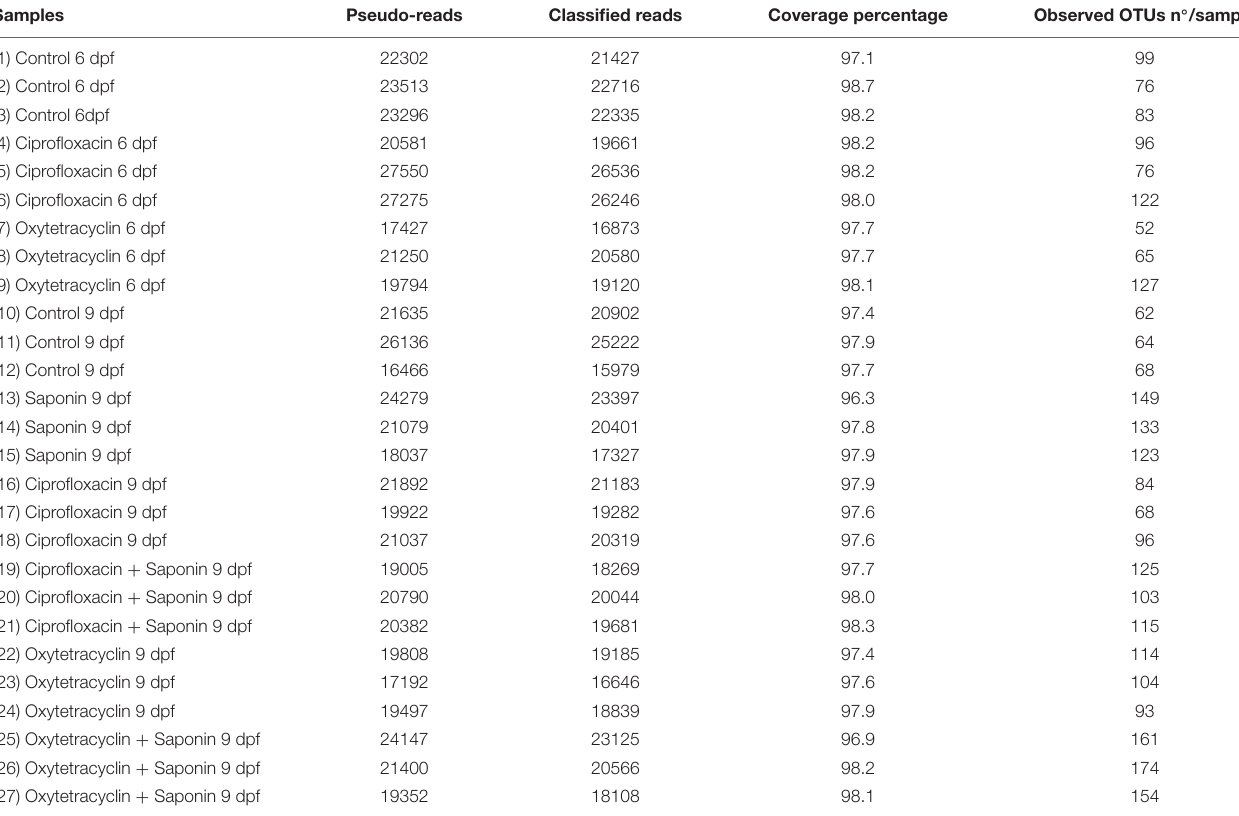
TABLE 2 | Control quality measurements for all the samples: pseudo-reads, classified reads, coverage percentage and number of observed OTUs per sample.